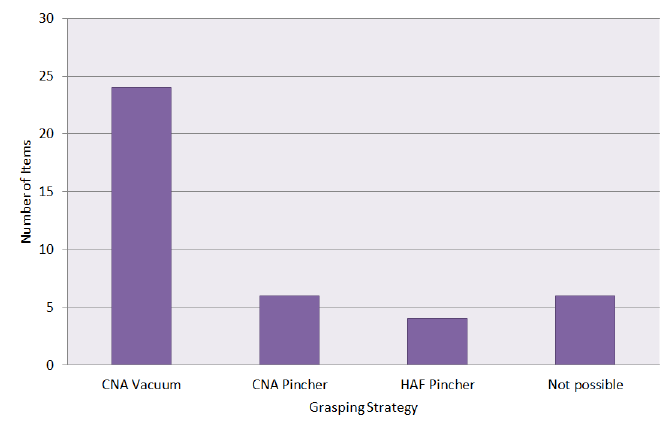
Figure 13. Number of items per grasping